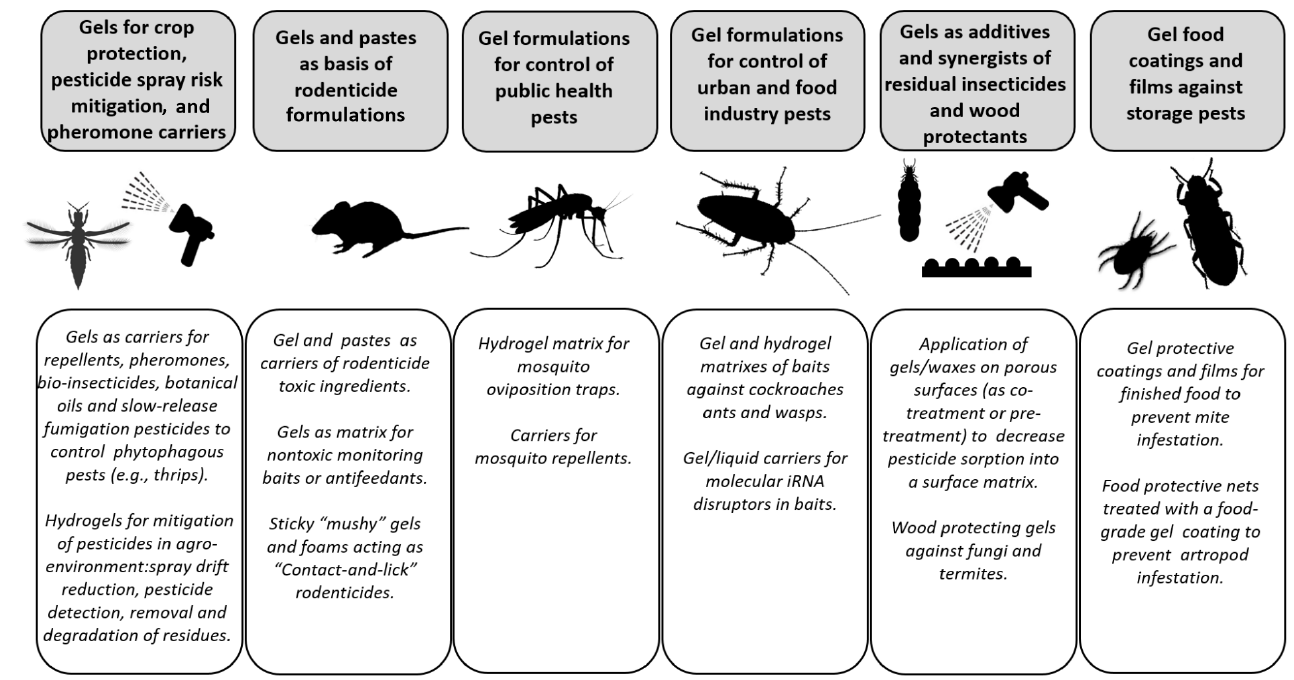
Figure 1. Graphical illustration of usage of gels—including hydrogels—in various areas of pest control and mitigation of pesticide environmental impacts.